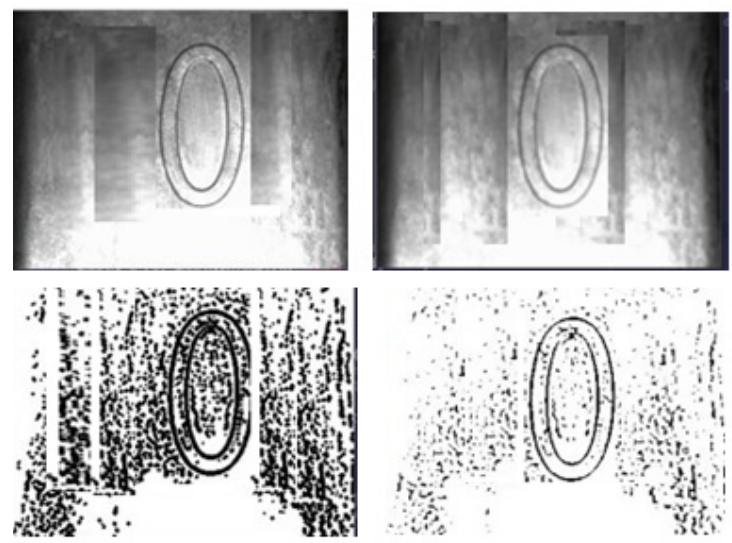
Figure A2. Segmentation applied to the images captured by the recognition system.